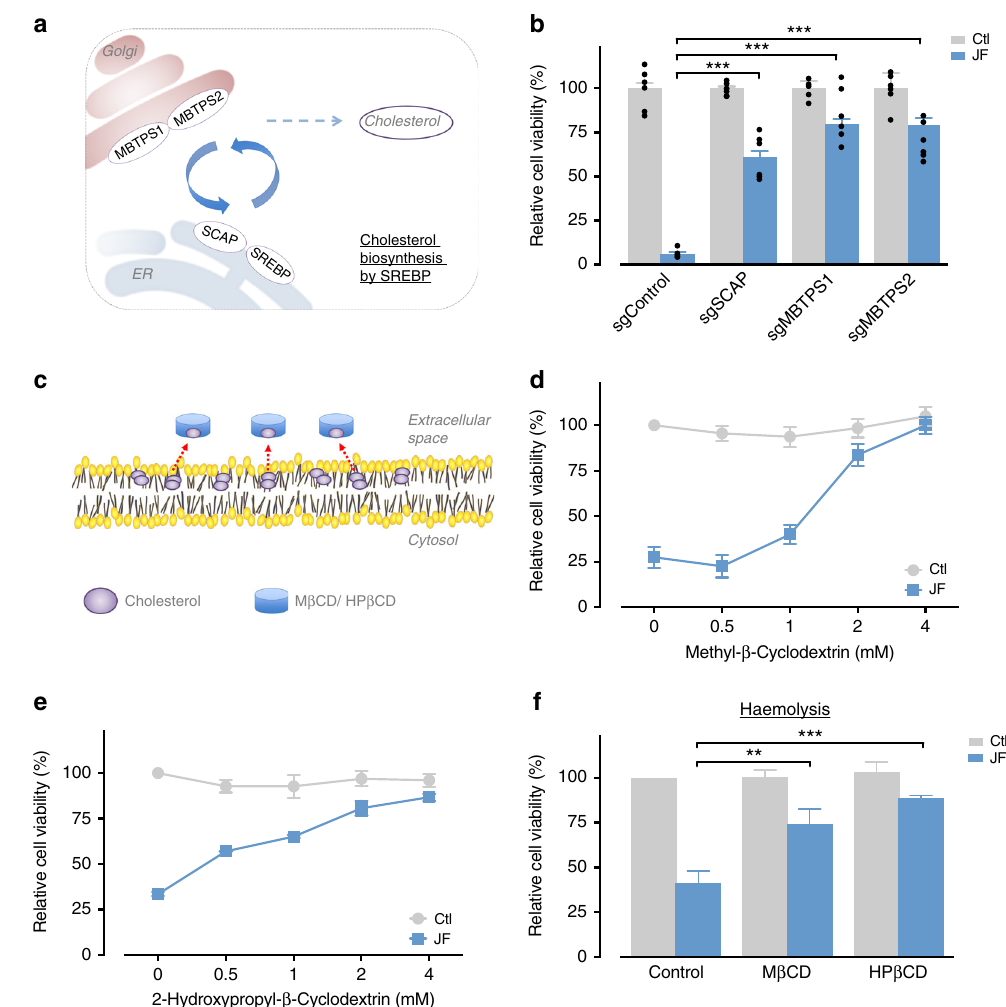
Fig. 6 Cholesterol is required for jelly fi sh venom killing. a Schematic representation of the SREBP pathways in cholesterol biosynthesis. b Depletion of SCAP, MBTPS1 and MBTPS2 conferring resistance to jelly fi sh venom (2 µ g/ml) in HAP1 cells ( n = 6). c Schematic representation of the function of M β CD and HP β CD to remove cellular cholesterol. d , e The depletion of cellular cholesterol reduces jelly fi sh venom-induced cell death. HAP1 cells were pre-treated with the indicated concentration of d M β CD or e HP β CD for 45 min, washed to remove M β CD and HP β CD, and treated with jelly fi sh venom (1 µ g/ml) for 24 h ( n = 3). f Mouse erythrocytes were pre-treated with M β CD and HP β CD for 5 min and treated with jelly fi sh venom (2 µ g/ml) for 1 h ( n = 3). All data represented as mean ± S.E.M. One-way ANOVA followed by Tukey ’ s post hoc test, * p < 0.05; ** p < 0.01; *** p <